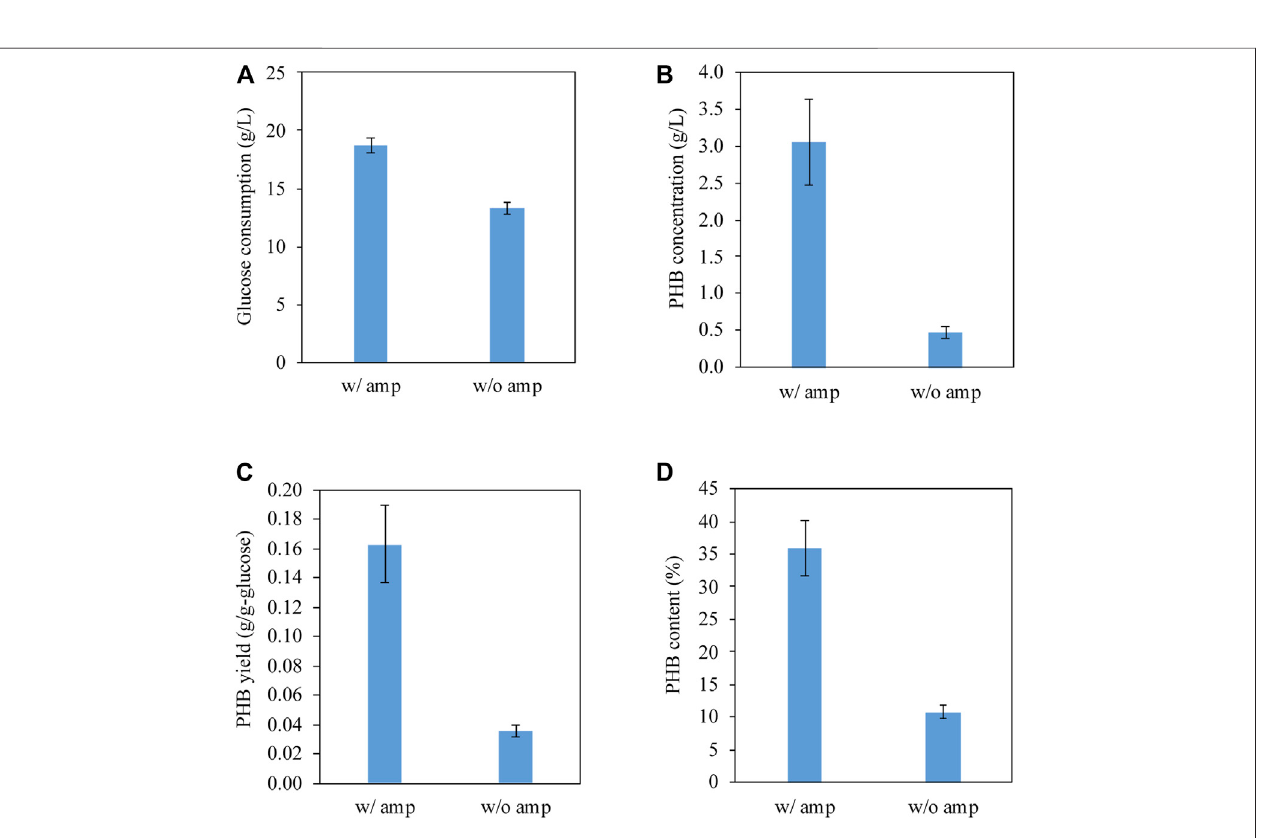
FIGURE 3 | (A) Glucose consumption, (B) PHB concentration, (C) PHB yield, and (D) PHB content of E. coli BL21 (DE3)/pPHB01 with and without ampicillin supplementation. The initial glucose concentration for conditions of with and without amp were 19.6 BL0.4 and 18.7 .40.5 g/L, respectively. Errors represent standard deviation with n =